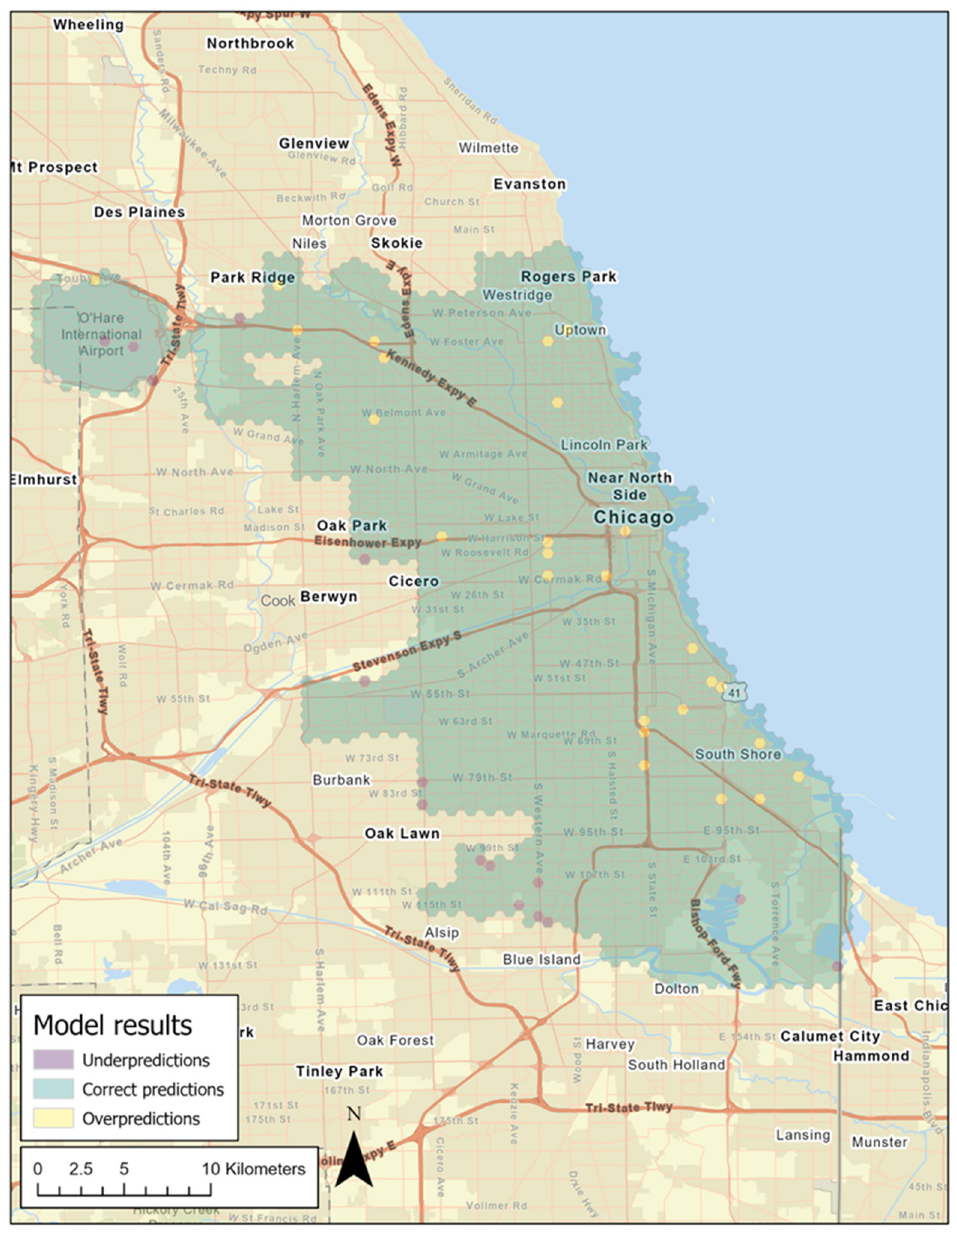
Figure 2. Neural network residuals. The green cells are those the model predicted correctly, while the purple cells are underpredictions (the model predicts that the hexagonal cell is a low prostitution arrest cell when it is a high prostitution arrest cell). Conversely, the yellow cells are overpredictions (the model predicts high prostitution arrests in a low prostitution arrest cell).